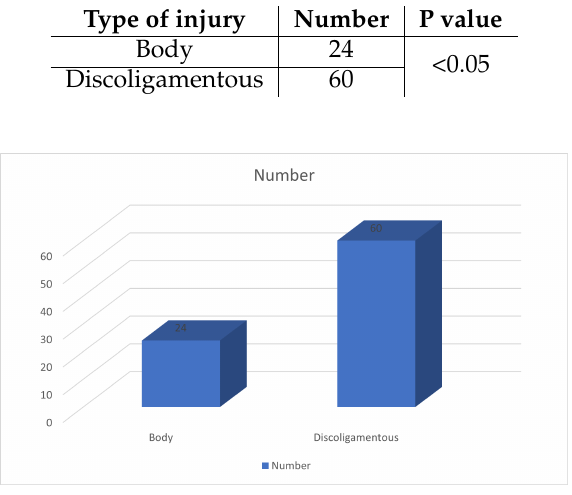
Figure 3. Graph III Type of injury noted in patients